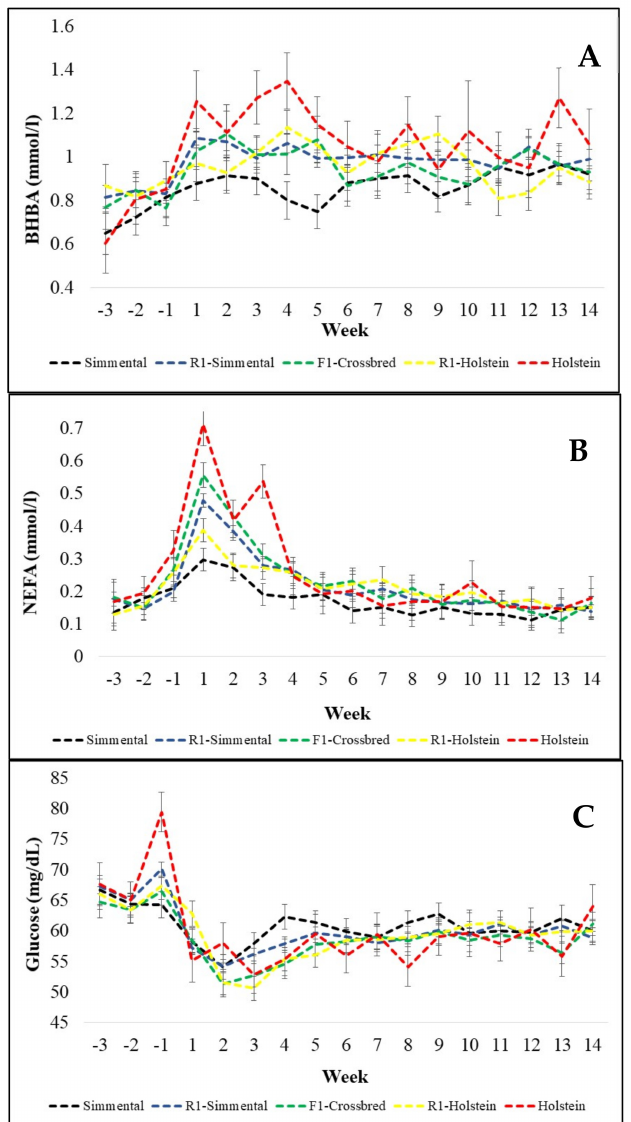
Figure 2. Weekly means of beta-hydroxybutyrate (BHBA) ( A ), nonesterified fatty acids (NEFA) ( B ), and glucose ( C ) between week three before calving and week fourteen after calving for purebred Holstein, Simmental cows, and their